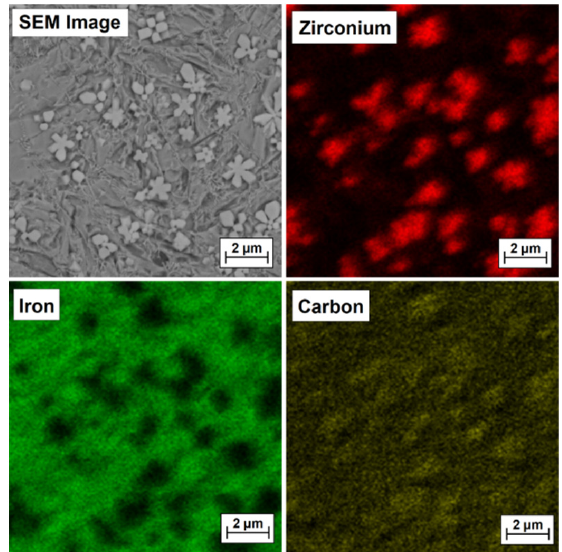
Figure 11. Microstructure and EDS mapping of Fe/ZrC coating produced using a laser beam power of 700 W—middle area of melted zone .